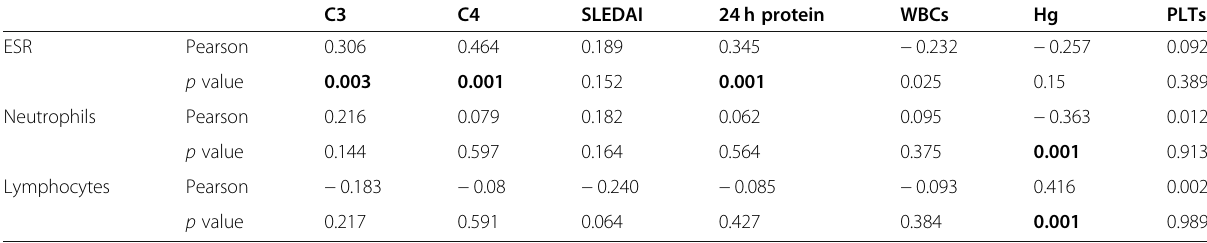
disease activity index, RDW red cell distribution width, C3 complement 3, C4 complement